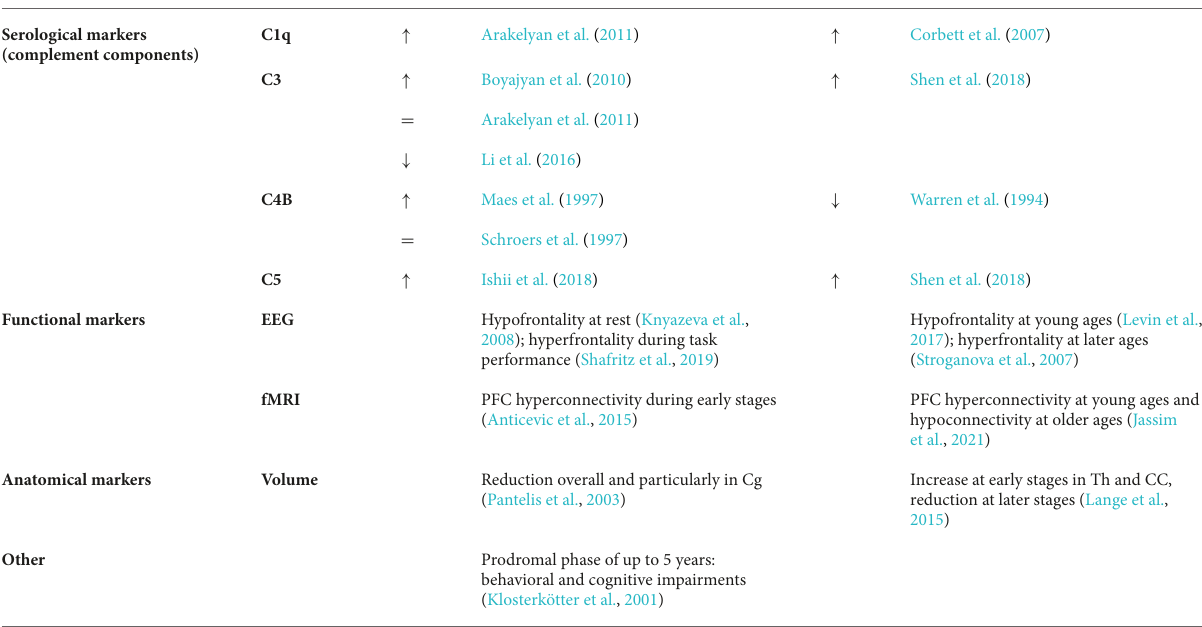
TABLE 1 Biomarkers of neuropsychiatric